Question: In a single sentence, describe what this figure presents.
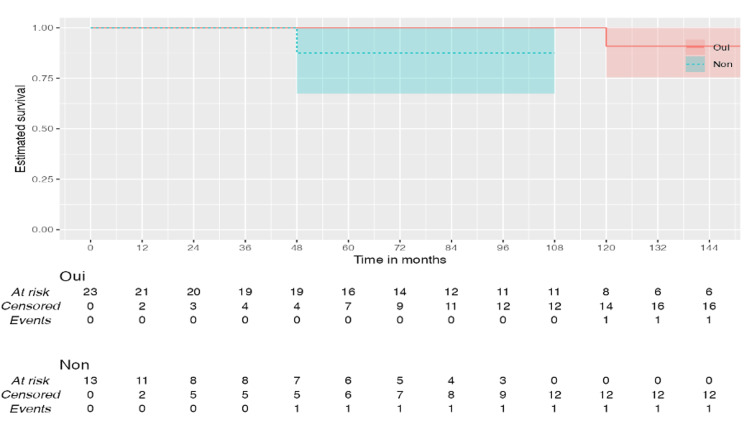
Answer: Kaplan-Meier survival curves according to the occurrence of complications